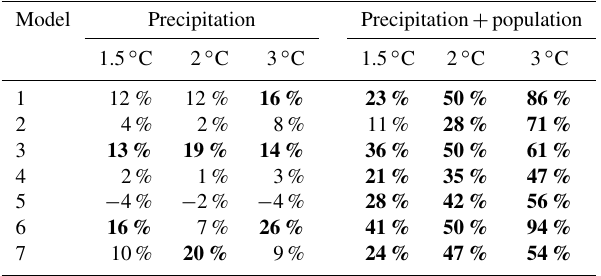
Table 6. Change in the probability of a damaging event in the Va- lencian Community for the 70th damage percentile and the three warming periods with the mean 24h precipitation as explanatory variable (left) and mean 24h precipitation and population (SSP5) as explanatory variables (right). The marked cells show statically significant ( p value < 0.05) increases (bold) and decreases (italic) in relation to the reference period